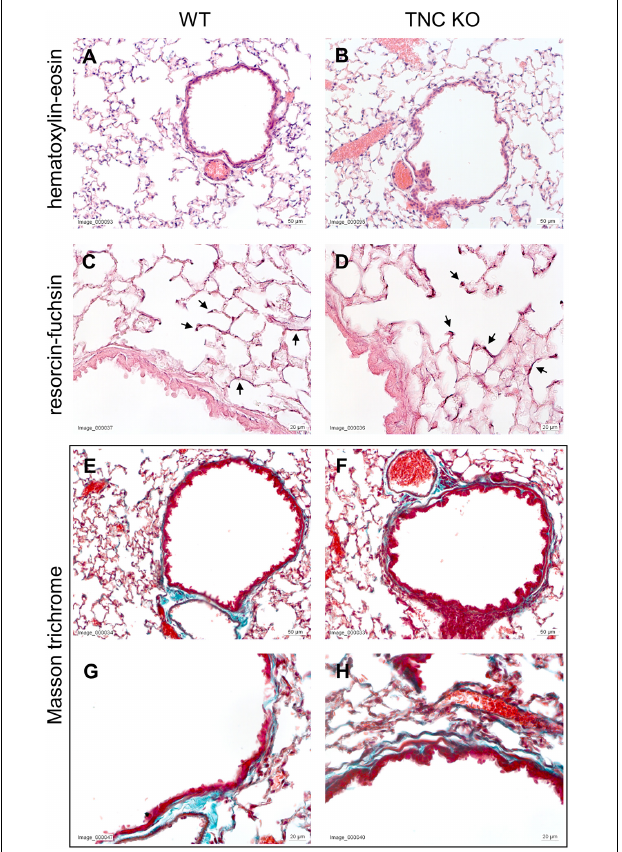
FIGURE 1 | Histological analysis of old TNC-deficient and WT lungs. Representative images of lung sections of female TNC KO and WT lungs at 18 months of age. Five µ m lung sections were stained with the following staining; (A,B) : hematoxylin-eosin for general morphology; (C,D) : resorcin-fuchsin for elastin (dark pink staining; black arrows); (E–H) : Masson trichrome for collagen (blue-green staining). WT: N = 3–4 animals/gender and TNC KO: N = 5